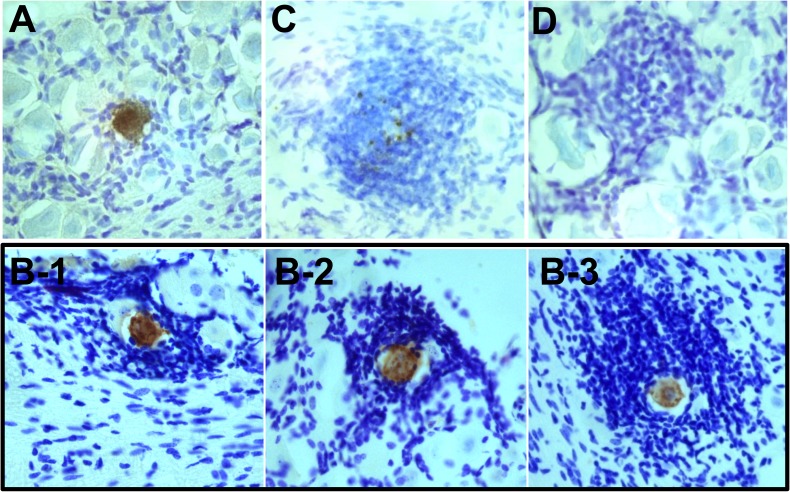
HSV reactivation is associated with an inflammatory response and neuronal destruction.Latently infected mice were subjected to hyperthermic stress and ganglia were harvested at 20–48 h phs. HSV proteins were first detected in the whole ganglia and TG were subsequently embedded, sectioned at 10 μm, and counterstained with cresyl violet, as described in Methods. (A) HSV protein positive neuron (brown) not surrounded by inflammatory infiltrate. (B) 3 examples of intact HSV antigen positive neurons (brown) surrounded by various sizes of inflammatory cuffs in the ganglia following reactivation in vivo. (C) Fragmented HSV protein positive neuron (brown) surrounded by an inflammatory cuff. (D) Nodule of cells in a neuronal region of the ganglia in the absence of viral protein detection.